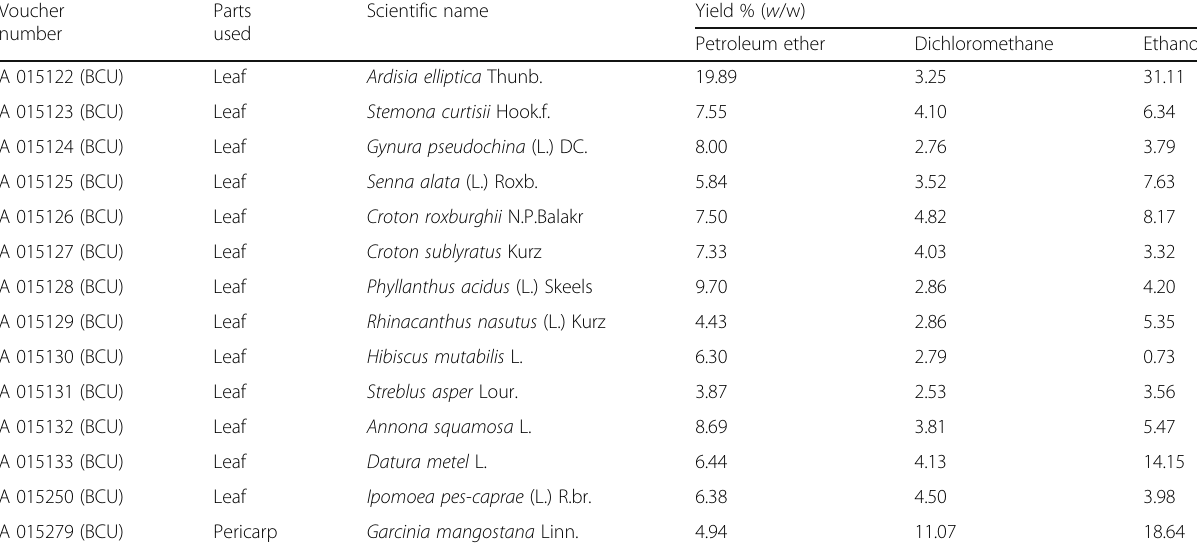
Table 1 Extracts of 14 Thai plants and their yields based on